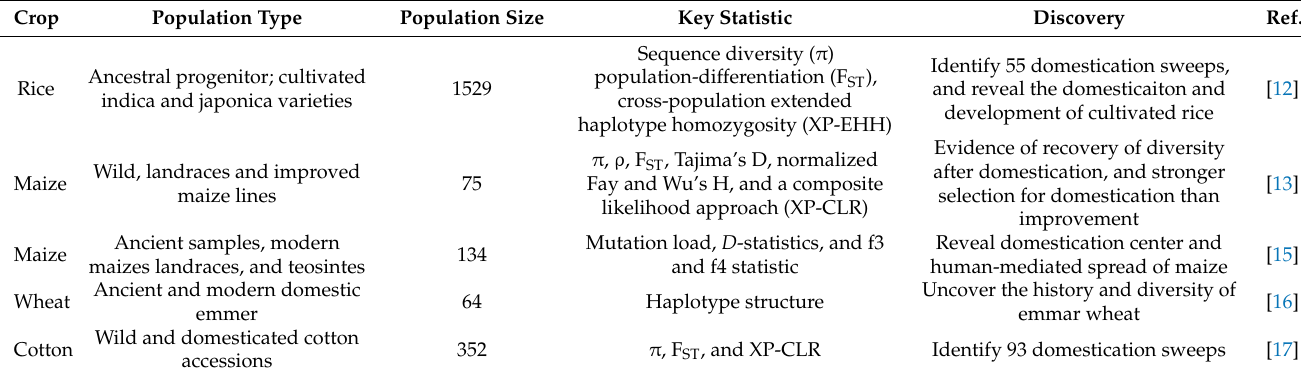
Table 1. The application of population genomics to crop